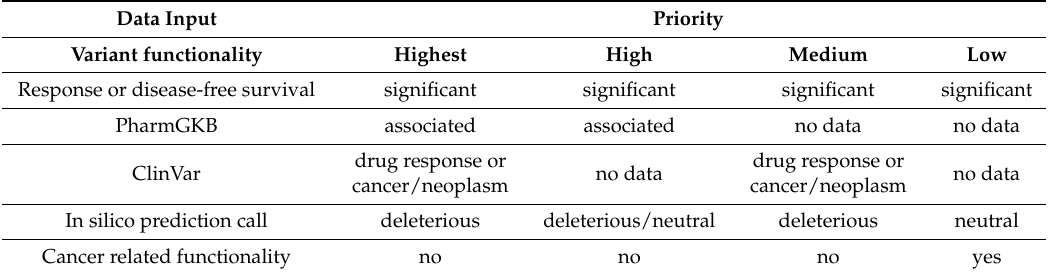
Table 4. Priorities and data input used for prioritization of variants for the validation